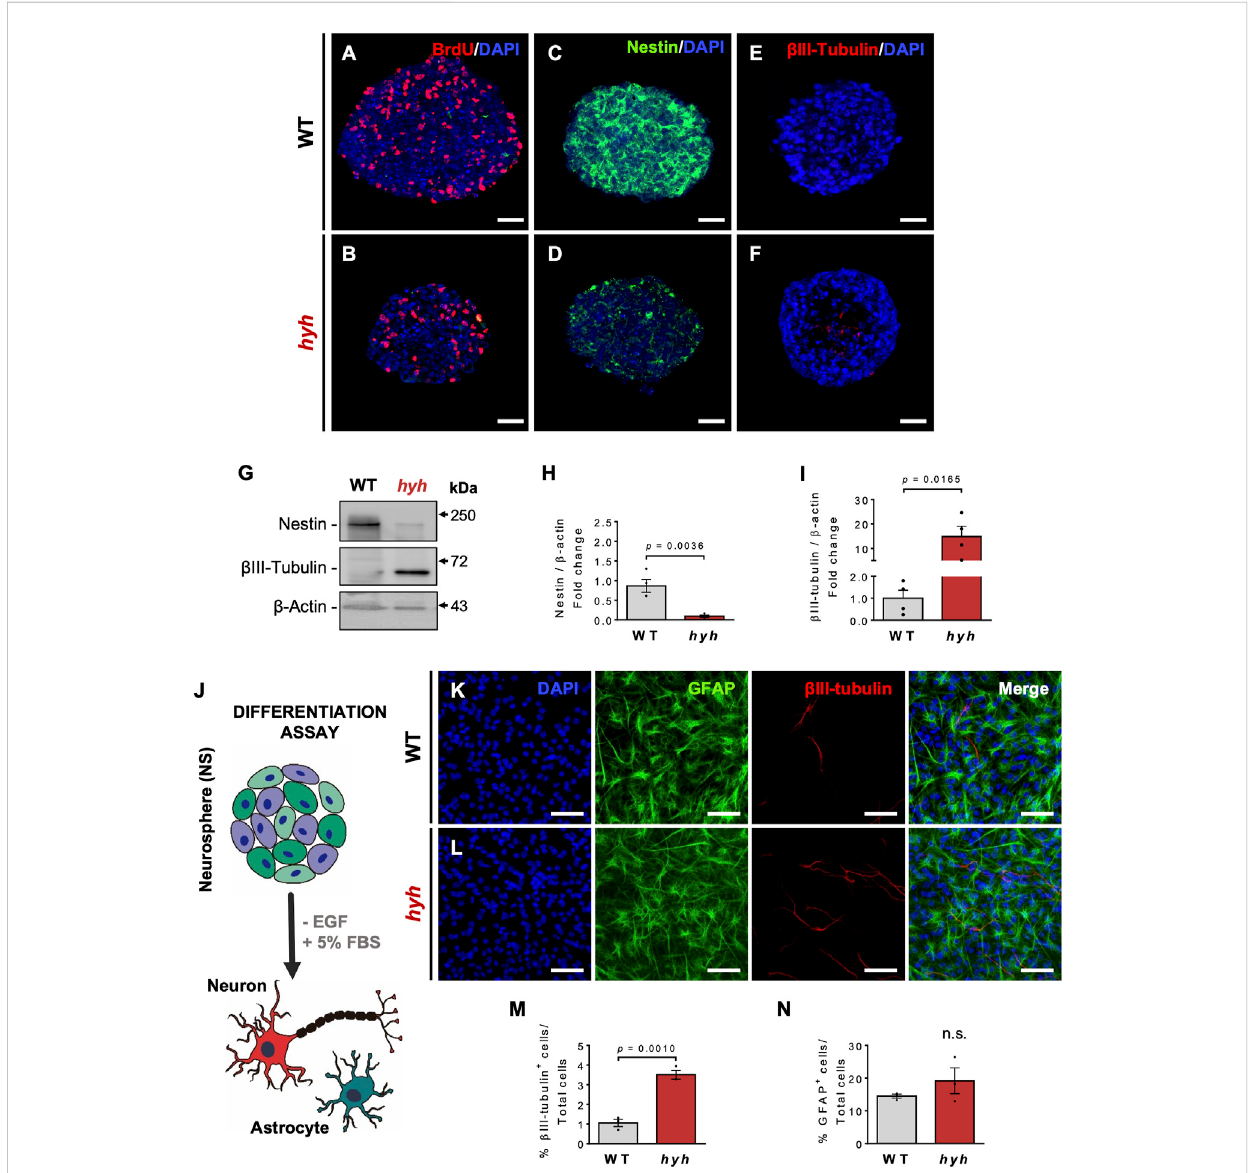
FIGURE 4 Increased neuronal differentiation of hyh-NSPCs is a cell-autonomous process. (A – F) . Representative immunostaining for BrdU (A,B) , Nestin (C,D) and β III-tubulin (E,F) of NSPCs from WT and hyh mice cultured for 7 days in vitro (DIV) using the neurosphere (NS) assay. (G) . Western blot analysis of WT and hyh NS lysates using antibodies against Nestin and β III-tubulin. β -Actin was used as loading control. (H,I) . Densitometric analysis of Western blots in (G) .The data ispresented as mean± SEM, n=4. Differenceswith p < 0.05were considered signi fi cant (Student ’ st-testwith Welch ’ scorrection). (J) . Scheme depicting the differentiation assay of NS using a culture medium supplemented with 5% of fetal bovine serum (+FBS) and without epidermal growth factor (-EGF), for 10 days (10DIV). (K,L) . Immuno fl uorescence for GFAP and β III-tubulin in WT and hyh NS after 10 days of differentiation. Cell nuclei were stained with DAPI. (M,N) . Quanti fi cation of GFAP- and β III-tubulin-positive cells. The data is presented as the percentage of positive cells in the total number of cells (nuclei) (n = 3). Differences with p < 0.05 were considered signi fi cant (Student ’ s t-test with Welch ’ s correction). n. s. = no signi fi cant differences. Scale Bars: A-F = 30 µm; K-L = 50